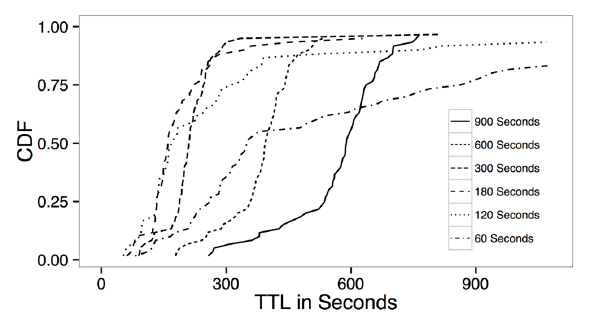
Figure 7: Energy Consumption for Each User with Scheduling